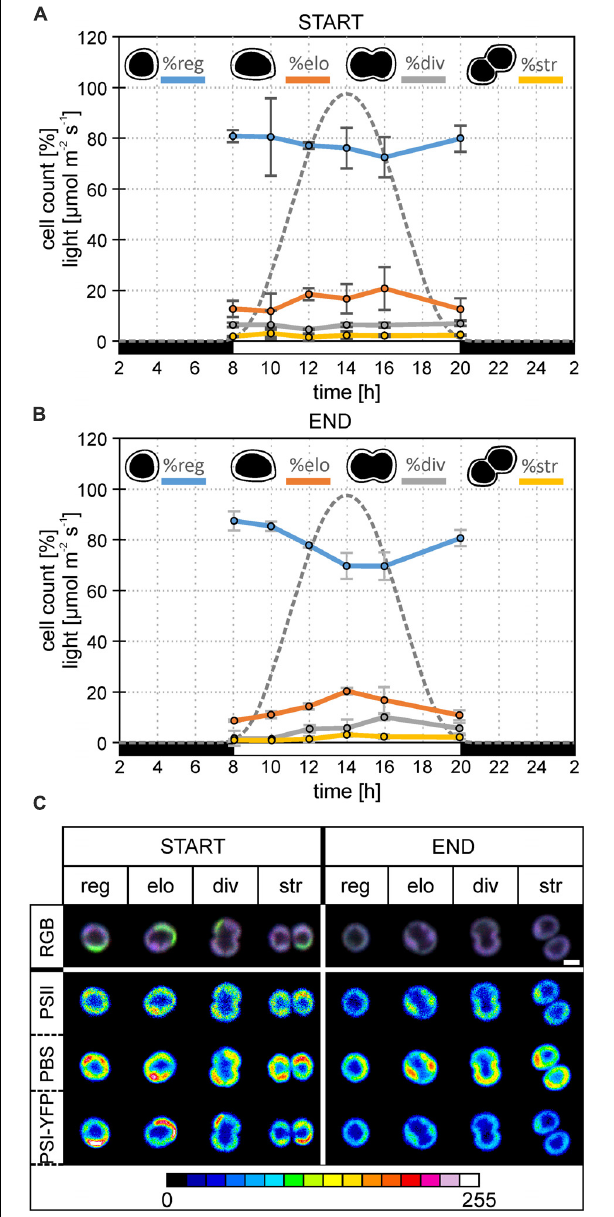
FIGURE 2 | Changes in the diel distribution of cell types and microdomain localization in the particular type of Synechocystis PSI-YFP cells. The original starting culture (“START”; cells acclimated to continuous light; days 2 and 3 in the bioreactor) was slowly acclimated in the bioreactor to the sinusoidal light- night cycle (“END”, days 13 and 14 in bioreactor). The light intensity profile is shown as a gray dotted line. The figure describes diel changes in the cell counts and microdomains organization in the four cell types based on their shapes, namely: “ reg ”—regular cells; “ elo ”—elongated cells; “ div ”—dividing cells; “ str ”—string cells after division. Total number of cells analyzed per day was between n = 709 and 1565. (A) Diel cycle of relative cell counts of four typical cells—regular, elongated, dividing, string—the start of bioreactor experiment (i.e., Synechocystis PSI–YFP acclimated acclimated to continuous light). Intensity of sinusoidal light during the day is marked by a gray dotted line. Data represent averages and SD from 2 days of experiment (days 2 and